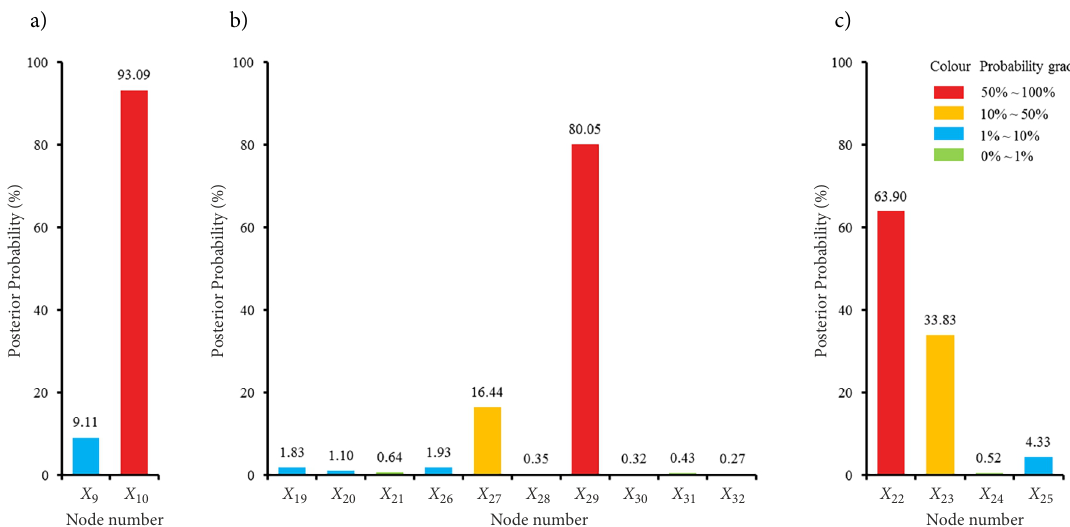
Figure 18. Diagnostic analysis results of tunnel water